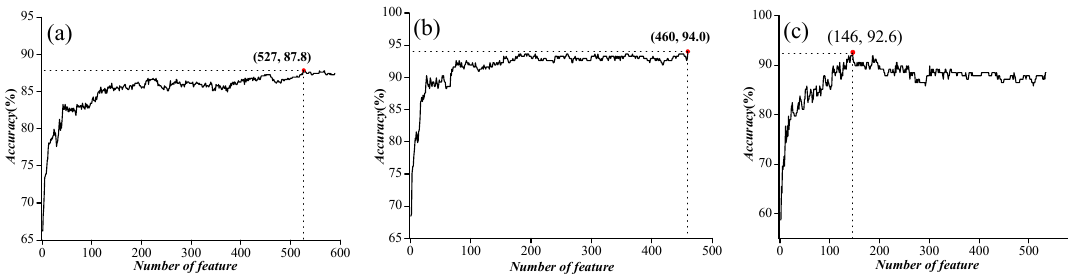
Figure 3. The feature selection results for three independent datasets. ( a ) Incremental feature selection (IFS) curve for ion channel (IC) vs. non-ion channel (NIC) prediction; ( b ) IFS curve for voltage-gated ion channels (VGIC) vs. ligand-gated ion channels (LGIC) prediction; ( c ) IFS curve for four types of VGIC prediction.